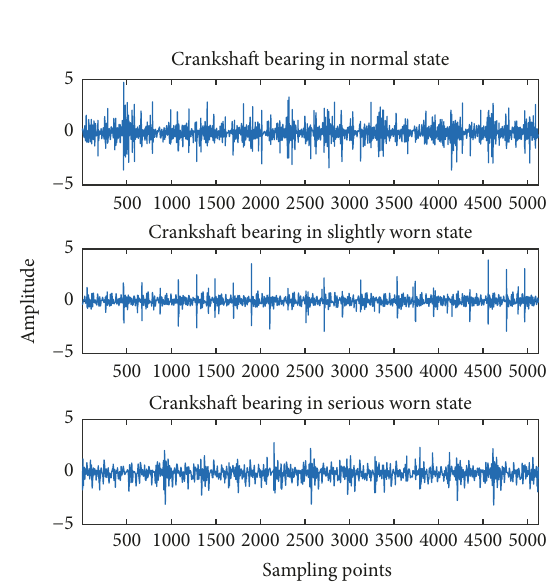
Figure 3: Time-domain signal of crankshaft